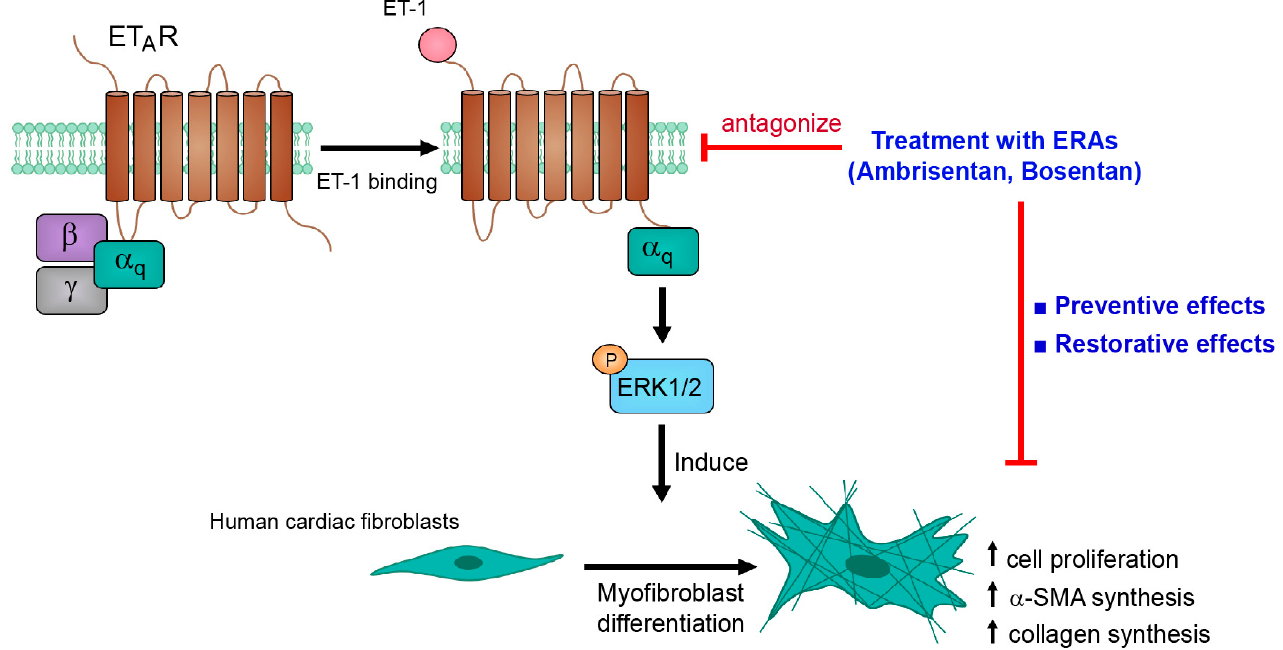
Figure 7. Schematic representing the ET A R/G α q /ERK signaling pathway for ET-1-inducd fibroblast activation and myofibroblast differentiation. ET-1 binding to ET A Rs leads to an activation of heterotrimeric G q protein, resulting in the dissociation of the G α q protein from the G βγ subunit. The activated G α q proteins transduced the signal through ERK1/2, which in turn induced fibroblast activation and myofibroblast differentiation. Interestingly, ETR antagonism using ERAs, ambrisentan and bosentan, exhibits cardioprotective effects by prevention and restoration of fibrotic actions of ET-1 in human cardiac fibroblasts. α -SMA: α -smooth muscle actin; ET-1: Endothelin-1; ERAs: endothelin receptor antagonists.